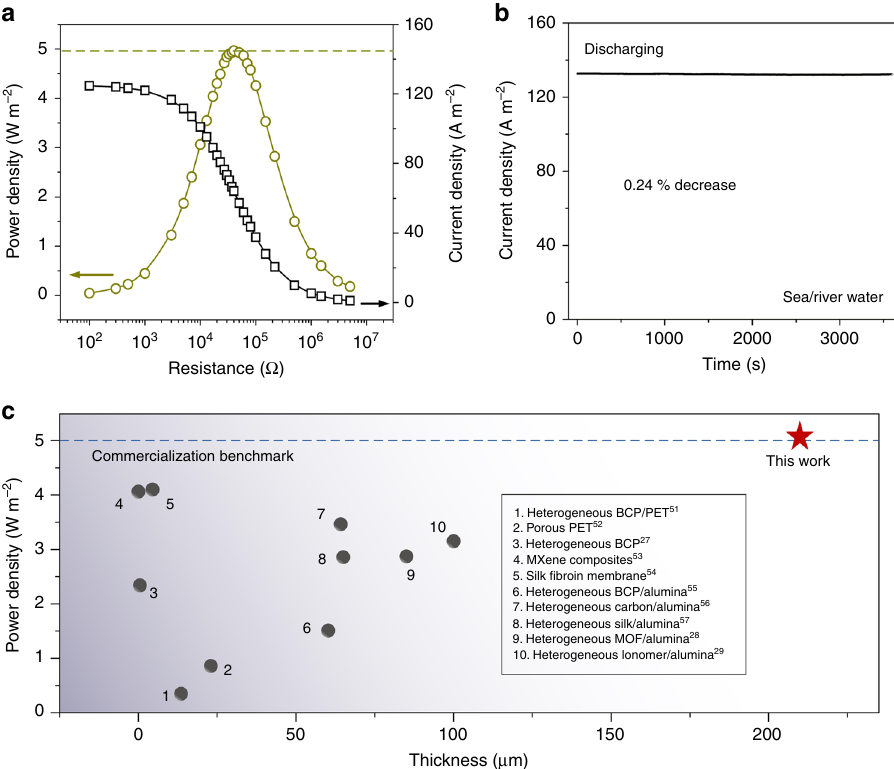
Fig. 5 Enhanced osmotic energy conversion with natural water source. a When we mix the real sea water with river, the power density could achieve ~4.97 W m − 2 . Data statistics indicate the average power density are 5.06± 0.33 W m − 2 . b Without electrolyte solution replenishing, the corresponding diffusion current only undergoes 0.24% decrease in an hour, indicating that the heterogeneous membrane can ef fi ciently stabilize local concentration gradient and promote continuous osmotic energy conversion. c Comparison of osmotic energy conversion performance with the reported macroscopic- scale porous nano fl uidic membranes based on the same testing